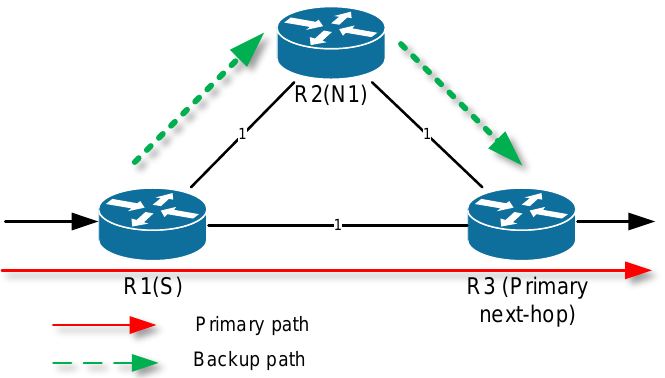
Figure 4. The LFA mechanism with correct metrics.